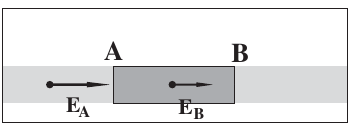
FIG. 3. The electric field at a point outside the resistor is greater than the electric field at a point inside the resistor.